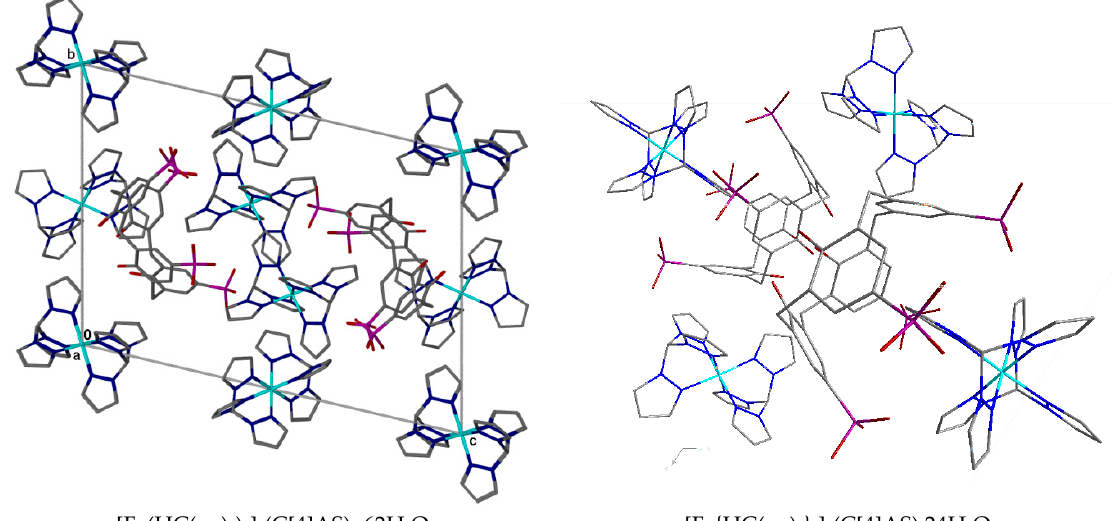
Figure 10. Fragments of crystal structures illustrated the inclusion of [Fe{HC(pz) 3 } 2 ] 2+ into the cavity of p-sulfonatocalix[4]arene (crystallization water is not shown for clarity).